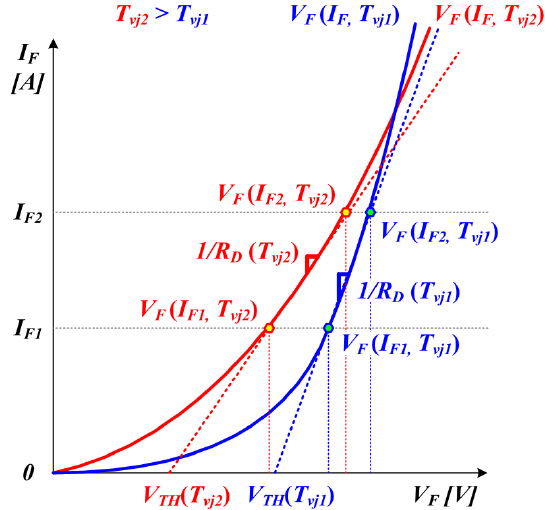
Figure 8. (cid:1848) (cid:3021)(cid:3009) and (cid:1844) (cid:3005) values according to (cid:1846) (cid:3049)(cid:3037) . Figure 8. V TH and R D values according to T vj